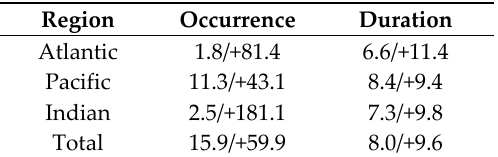
Figure 5. As in Figure 2, except for February months associated with the transitions in Figure 4. Table 2. Character of Southern Hemisphere blocking events per year as a function of region and season for all characteristics since the Wiedenmann et al. (2002) study. The change in the value is expressed as a